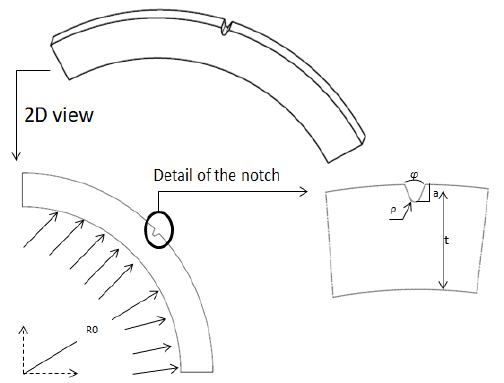
Table 1. Geometry properties and load.